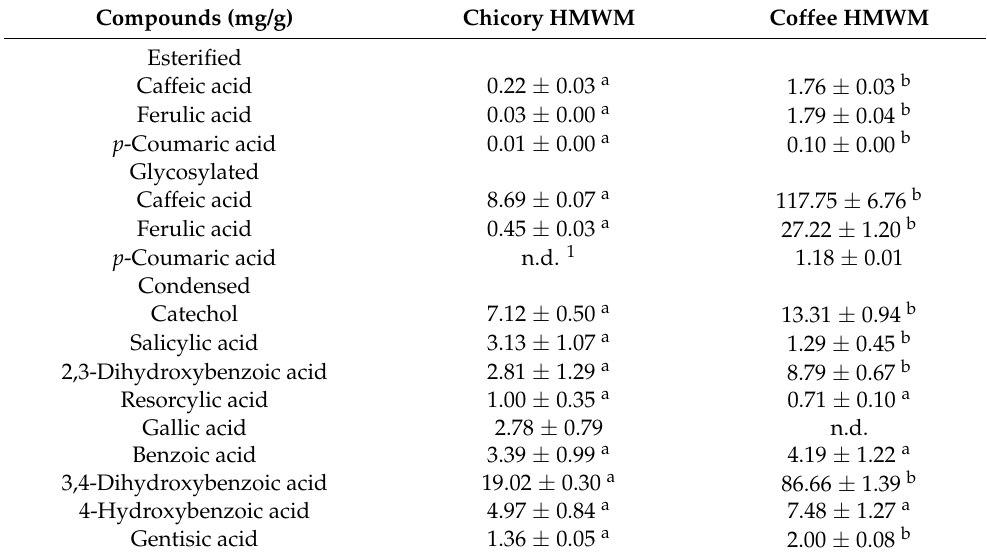
Table 2. Phenolic compounds identified in the high molecular weight material of instant chicory and instant coffee.